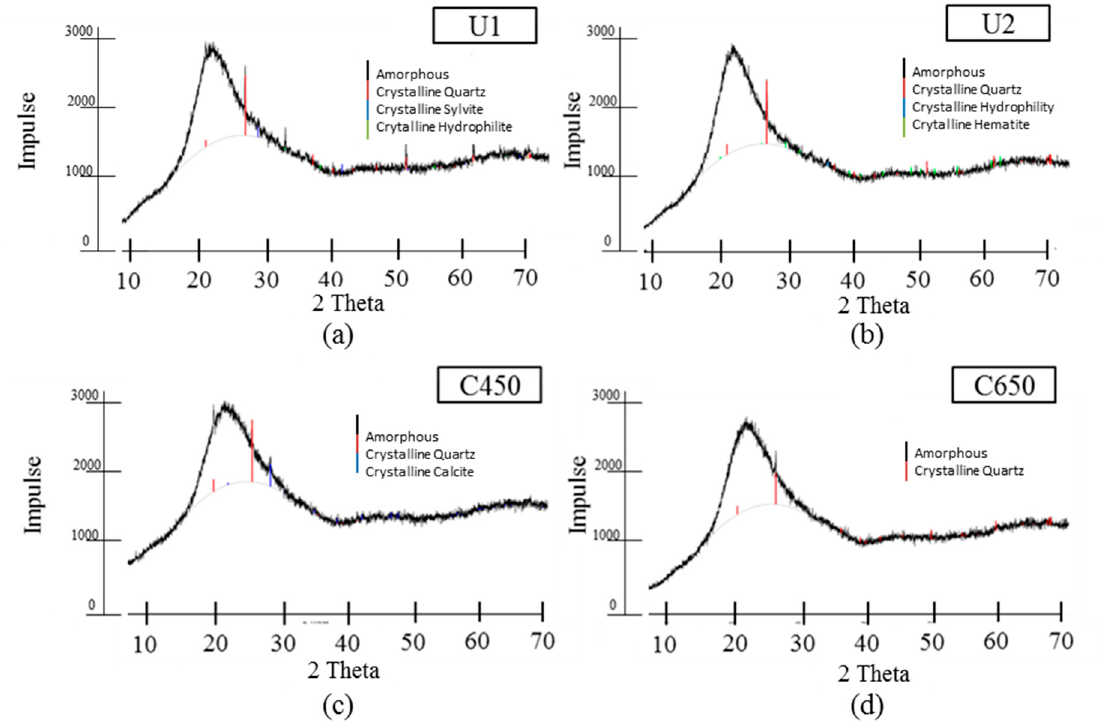
Figure 6. X-ray di ff raction (XRD) patterns of RHA samples ( a ) U1, ( b ) U2, ( c ) C450 and ( d ) C650.